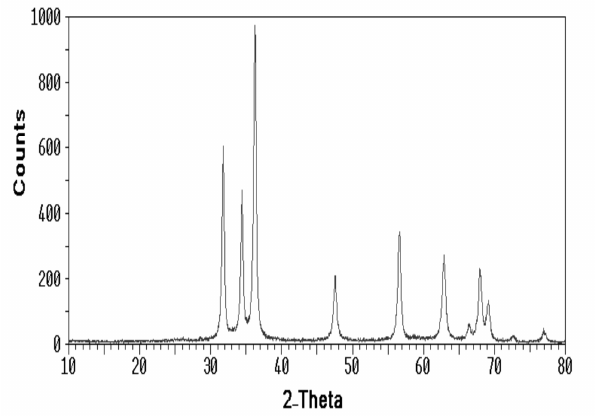
Figure 2. X-ray diffraction results of ZnO